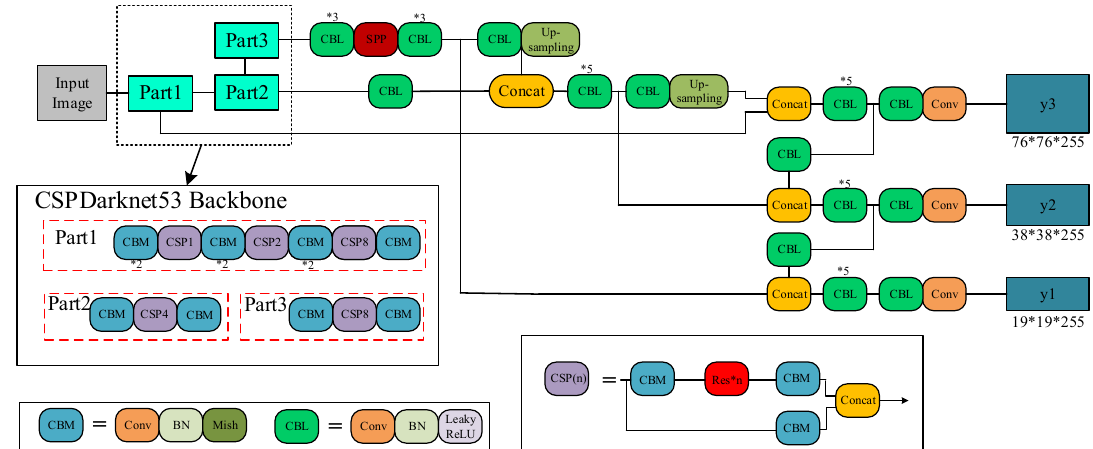
Figure 2. Structure diagram of the neural network for the building extraction algorithm.